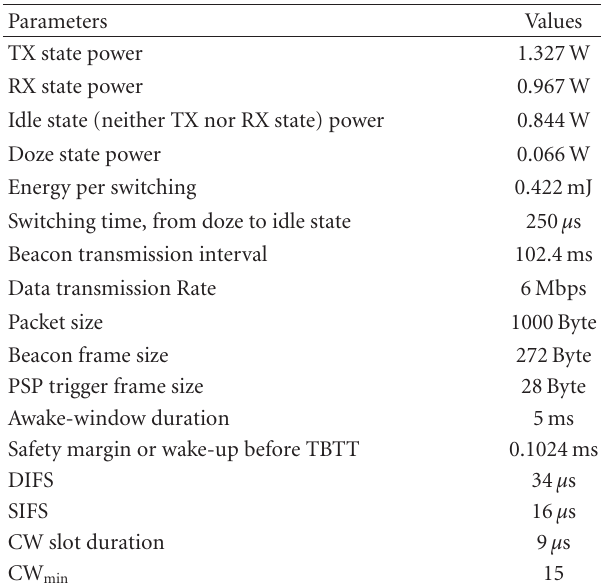
Table 1: Simulation parameters.